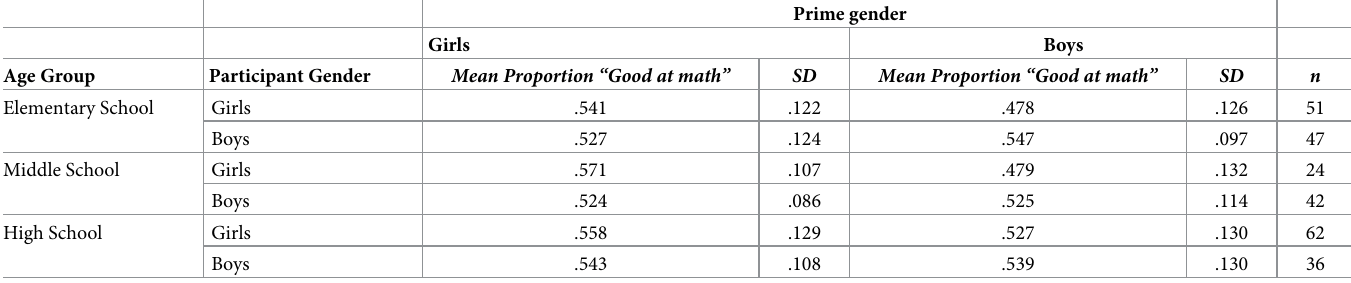
Table 1. Math implicit bias scores by age group, participant gender and prime gender.